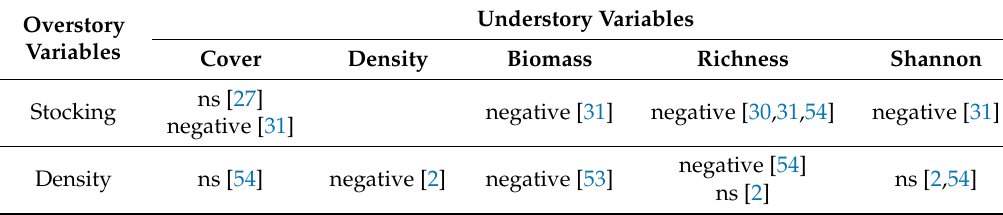
Table 6. Summary of results from the studies listed in Table 5. The table shows the e ff ect of stand stocking (including basal area and canopy cover) and stand density on five understory variables: plant cover, plant density, plant biomass, plant richness and the Shannon-Wiener index; ns—nonsignificant results / nonconclusive